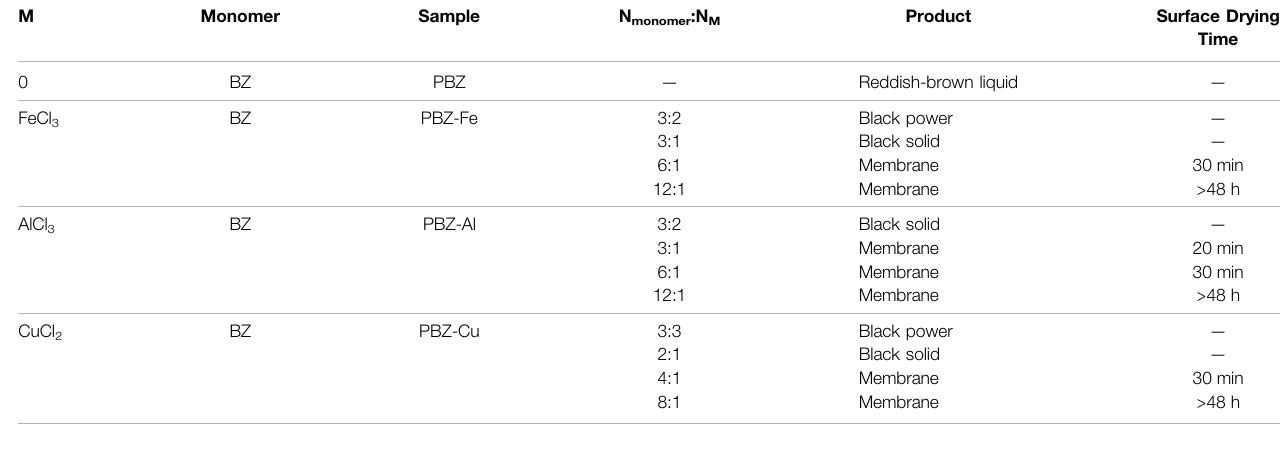
TABLE 1 | Optimization of the reaction ratio of MCl x and BZ.